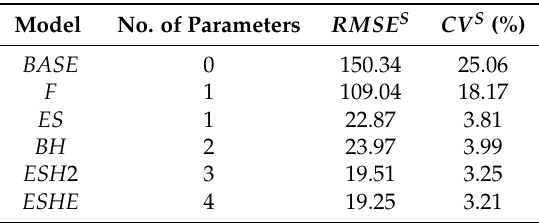
Table 11. Comparison of leave-one-session-out LOOCV RMSE of various models.